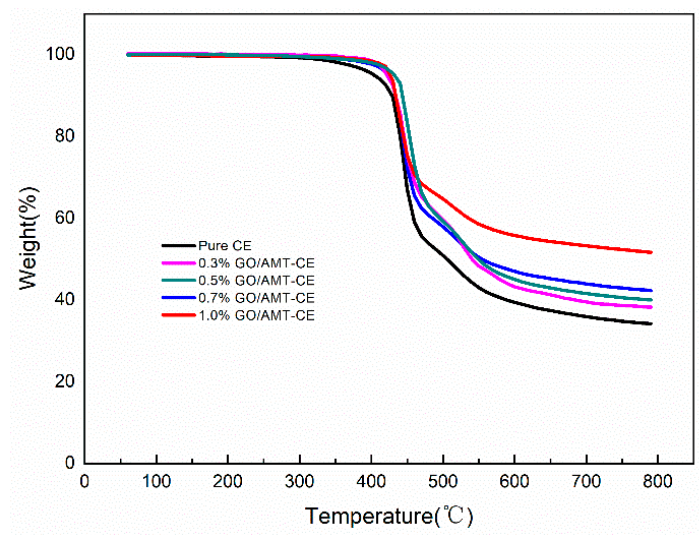
Figure 5. Thermal stability of GO/AMT-CE composites with different GO/AMT contents.